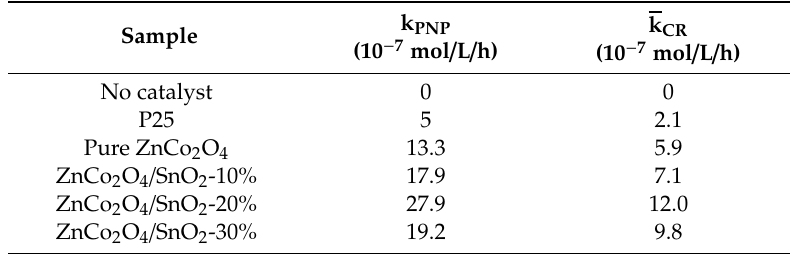
Table 2. Zero-order rate constants for the degradation of p-nitrophenol and congo red.